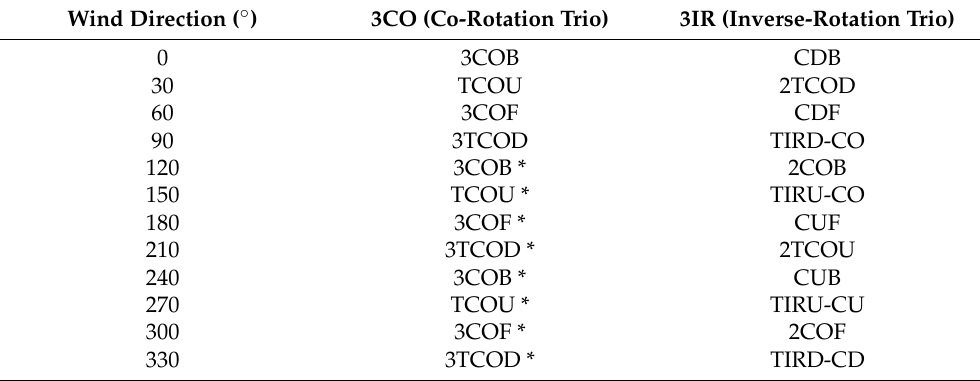
Table 2. Definition of the names of specific layouts in 12-wind-direction configurations (3CO and 3IR) in a closely spaced VAWT trio. Layouts with * are repeated every 120 ◦ . Wind Direction ( ◦ ) 3CO (Co-Rotation